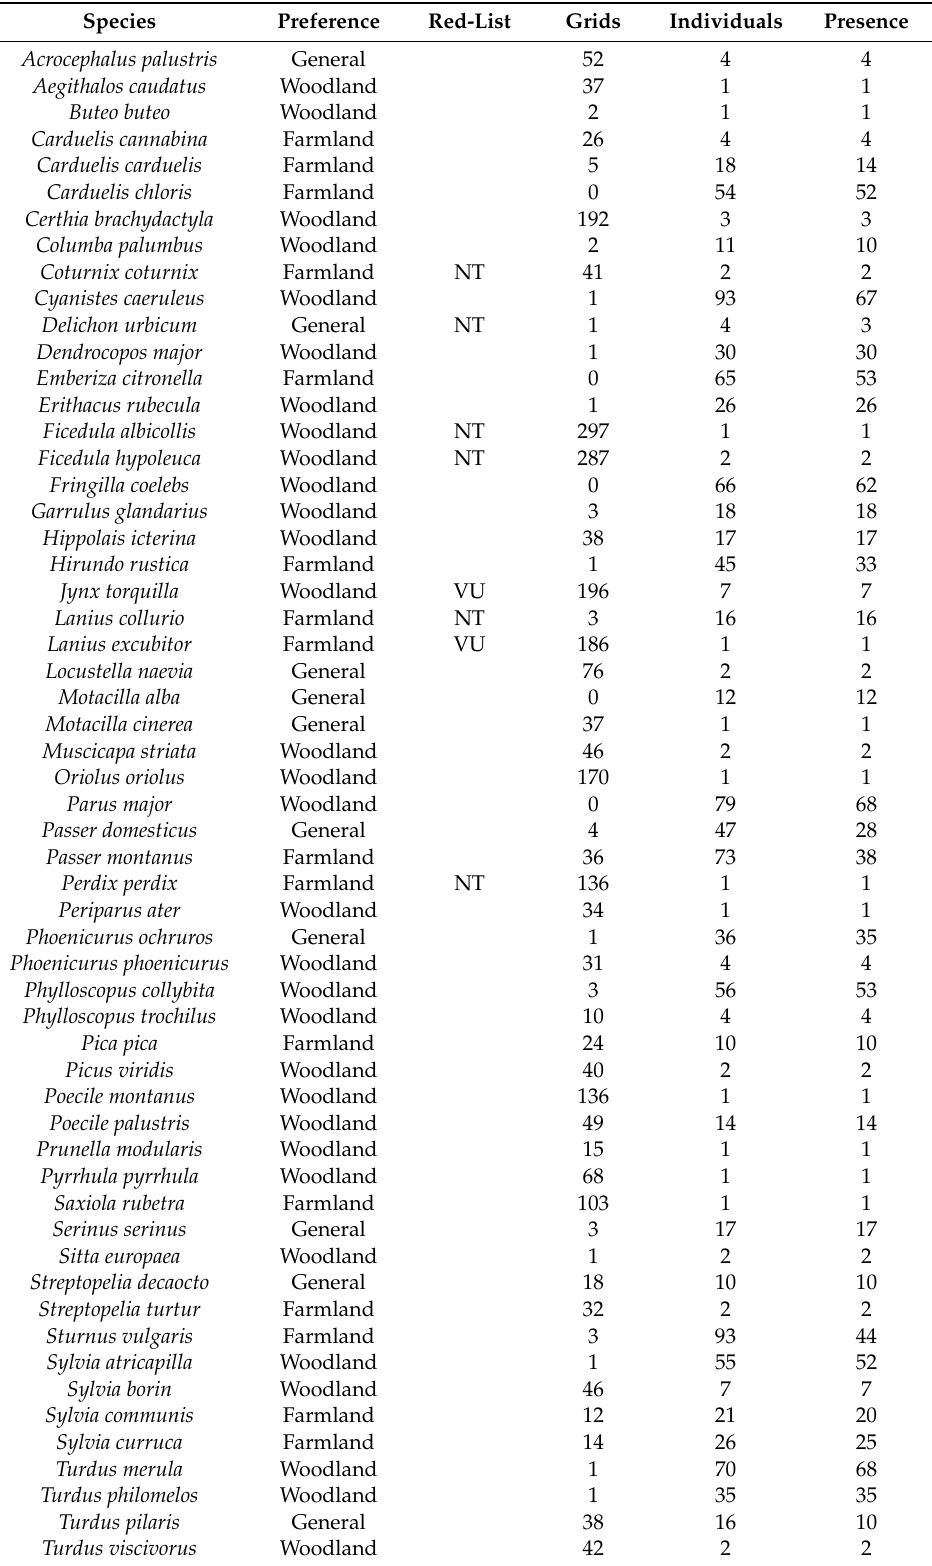
Table 2. Bird species of traditional fruit orchards in rural agricultural landscape of Pardubice Region, Czech Republic. Preferences, red-list categories, number of unoccupied grids in the Czech Republic (out of a total of 628 grids), number of individuals observed and heard, are indicated for presence at studied plots. VU = vulnerable, NT = near